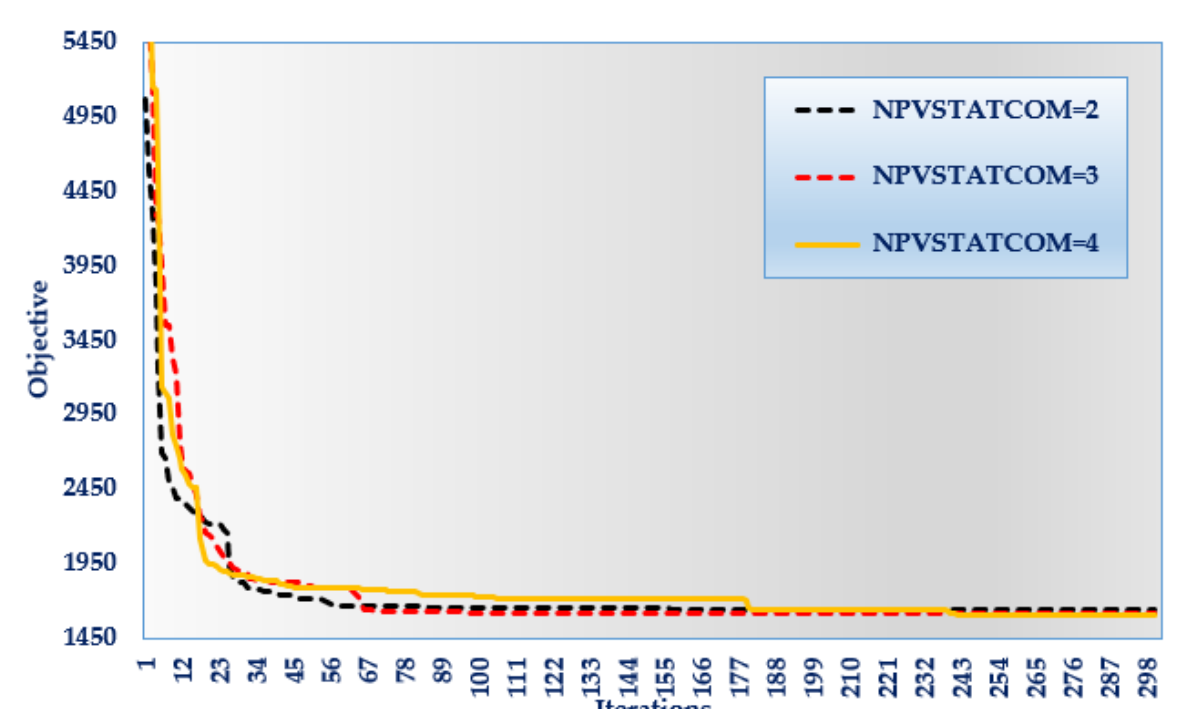
Figure 13. Convergence properties of HPO with varying the number of installed devices for IEEE 69-distribution feeder.